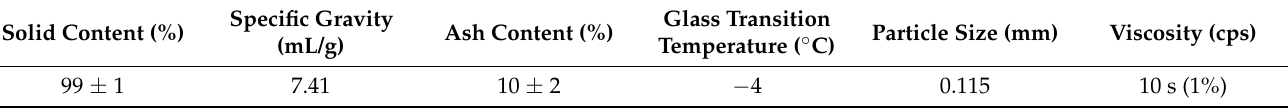
Table 4. Physical and chemical properties of redispersible emulsion powder.